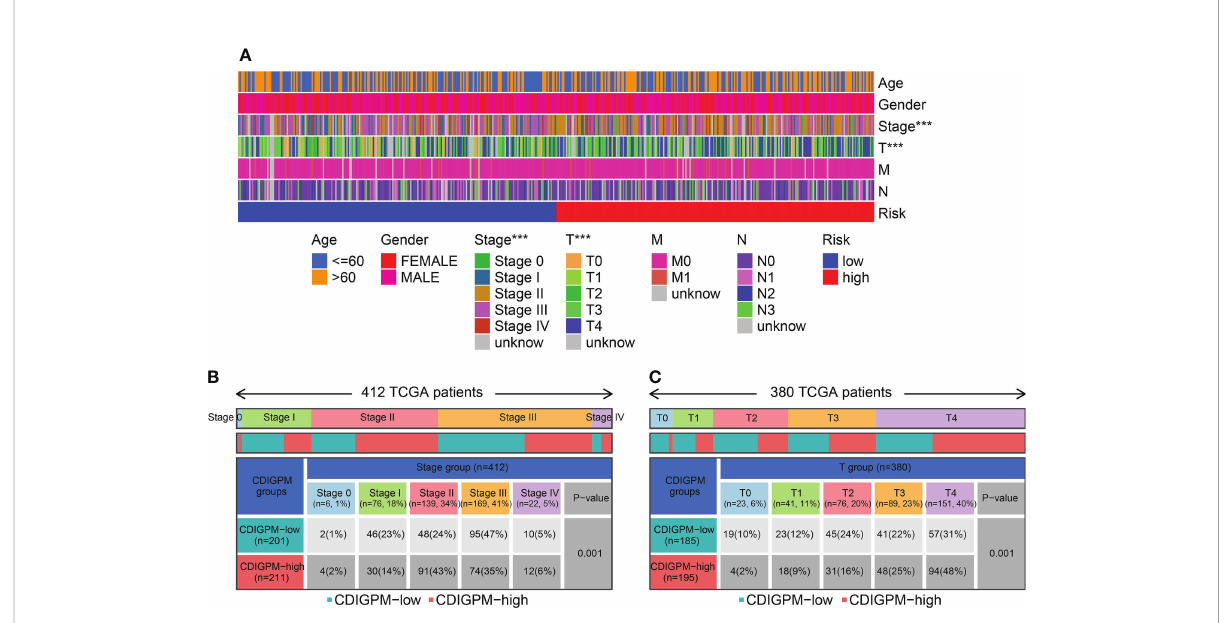
FIGURE 6 Relationship between CDIGPM and clinical subtypes. (A) The CDIGPM groups and clinical subtypes for SKCM patients in the TCGA cohort. Age, gender, tumor grade and TNM stage are shown as patient annotations. (B) Heat map showing the distribution of SKCM TNM stages (stage 0-IV) between high- and low-CDIGPM groups. (C) Heat map showing the distribution of SKCM grade (T0-4) between high- and low-CDIGPM groups. (***p < 0.001). CDIGPM: CD8 + T cells-associated immune genes prognostic model.